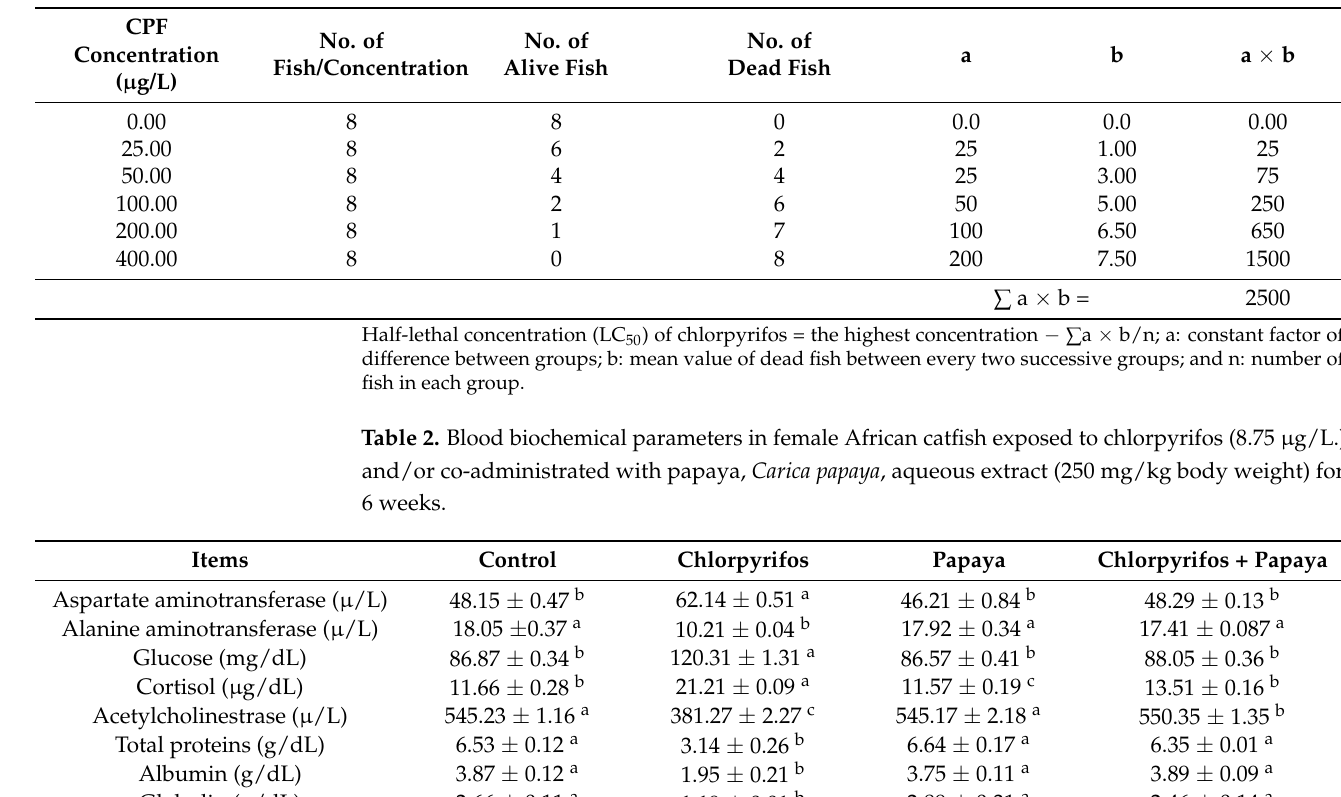
Table 1. Half-lethal concentration (LC 50 ) of Chlorpyrifos (CPF) in female African catfish, Clarias gariepinus .